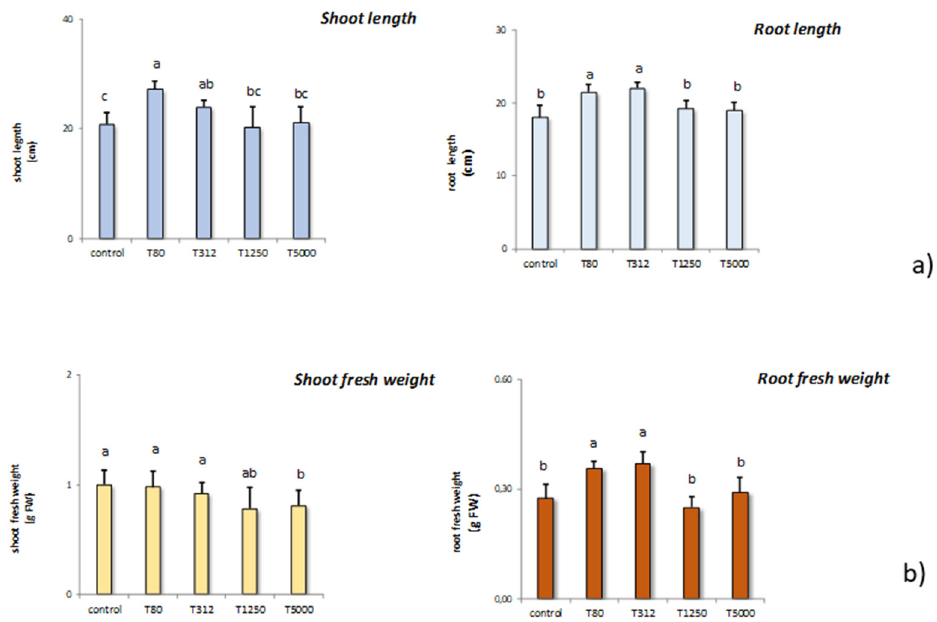
Figure 3. Effect of the treatment with LNP on the shoot and root length of maize samples compared to the untreated controls (T80, T312, T1250, and T5000 refer to LNP concentration applied to seed for priming ( a ); effects of the treatments with LNP on the shoot and root weight of maize seedlings compared to the untreated control ( b ). The values were recorded on seedlings at 14 DAS. Letters in the figure, if different, indicate statistically significant differences for p < 0.05 between treatments.